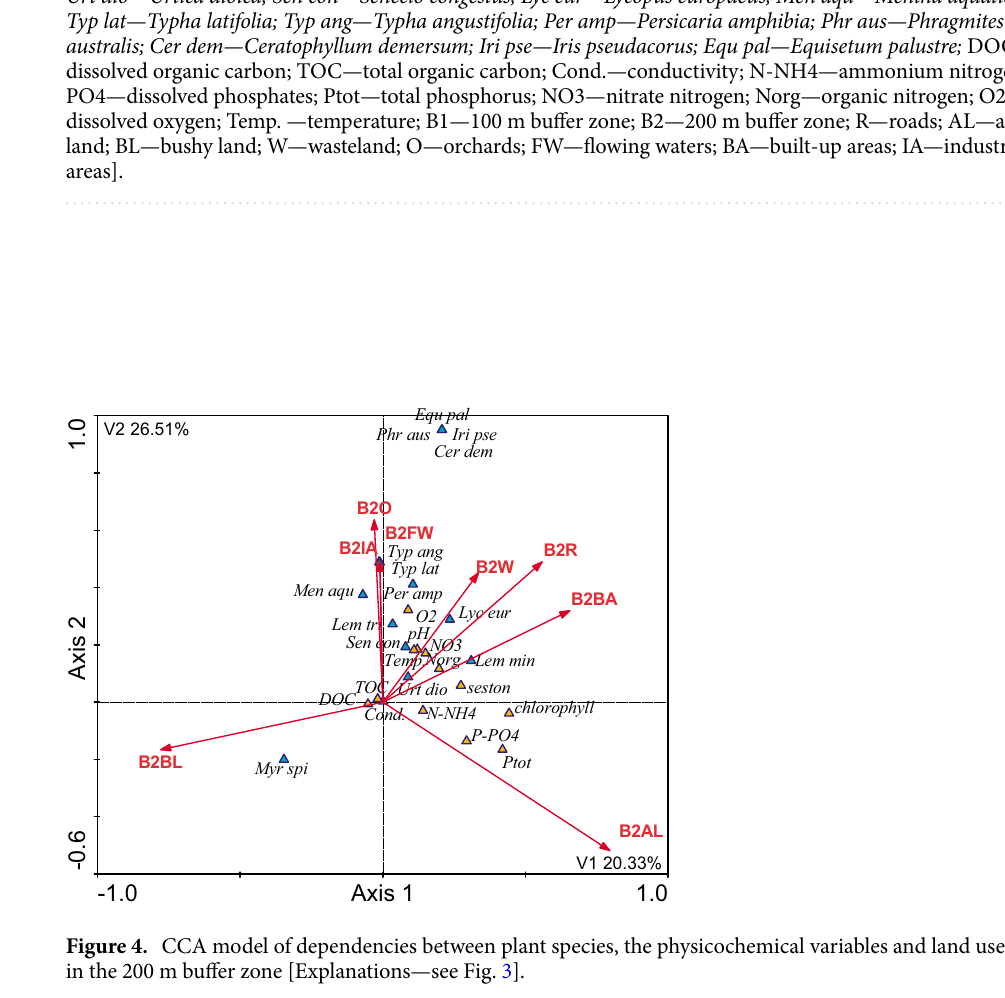
Figure 3. CCA model of dependencies between plant species, the physicochemical variables and land use types in the 100 m buffer zone [ Myr spi — Myriophyllum spicatum; Lem min — Lemna minor; Lem tri — Lemna trisulca;